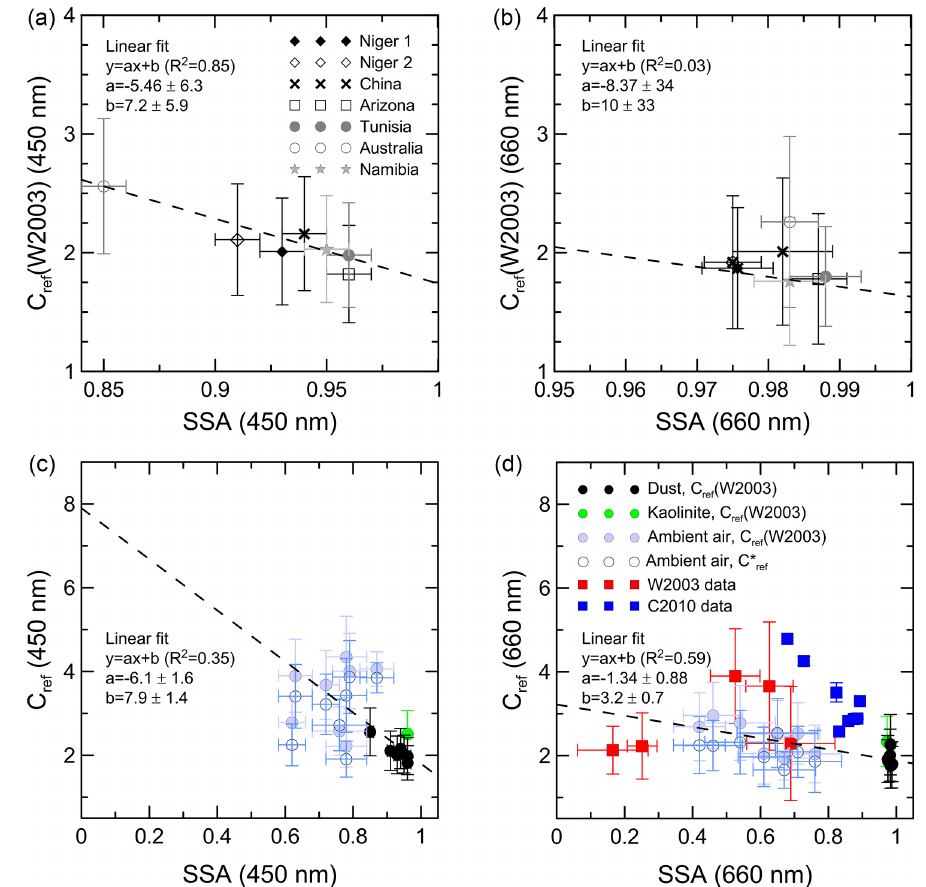
Figure 6. (a, b) C ref (W2003) (multiple scattering correction obtained by taking into account the loading effect correction using the parame- terizations by Weingartner et al., 2003) versus SSA at 450 and 660nm for mineral dust samples analysed in this study. Different symbols are used to distinguish between dust from different sources. As indicated in Table 2, the difference between C ∗ , C ref (W2003), and C ref (C2010) ref is very low for mineral dust aerosols. The uncertainty of SSA is the standard deviation over 2min data, while that of C ref (W2003) is cal- culated with the error propagation formula taking into account the uncertainty of β abs , ref and that of β ATT /R (W2003). (c, d) C ref versus SSA at 450 and 660nm for the different aerosol samples analysed in this study. Different symbols are used to distinguish between different aerosol types. Data for both C ref (W2003) and C ∗ (multiple scattering correction obtained while not taking into account the loading effect ref correction in Aethalometer data) are shown for ambient air aerosols, while for dust and kaolinite, for which the difference between the different formulations is very low, only C ref (W2003) is reported. Data from Weigartner et al. (2003) (W2003) ( C ref from their Table 3, and SSA extracted from their Fig. 4) and Collaud Coen et al. (2010) (C2010) (extracted from their Fig. 5) at 660nm are also shown in the plot for comparison. The results of the linear fits between C ref and SSA for mineral dust and for the entire data set are also shown in the